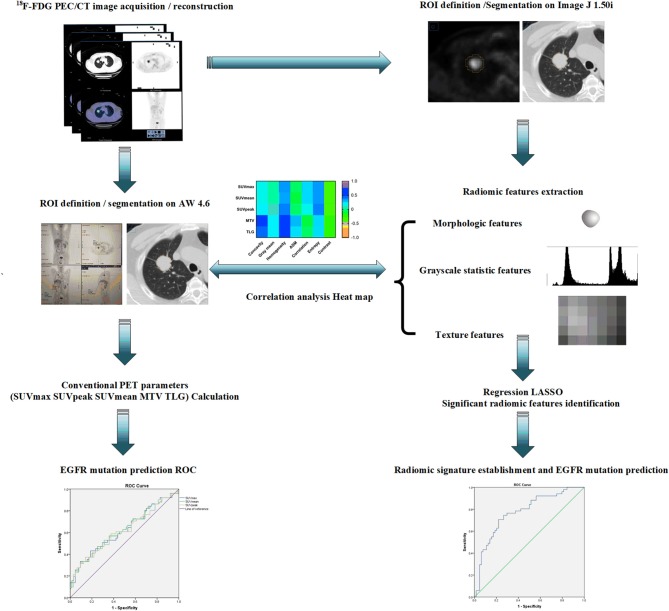
A schematic representation of a typical radiomic workflow used in this study for EGFR mutation prediction based on PET/CT images in NSCLC. EGFR, epidermal growth factor receptor; PET, positron emission tomography; CT, computed tomography; NSCLC, non-small cell lung cancer.